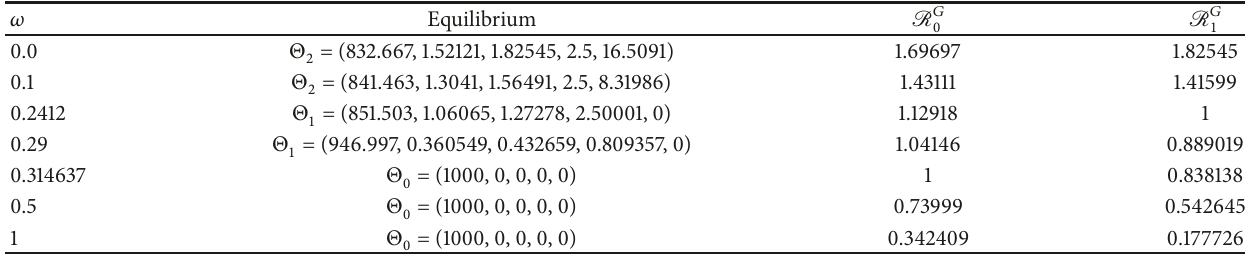
Table 2: The values of R 𝐺 0 and R 𝐺 1 for system (69)-(73) with different values of 𝜔